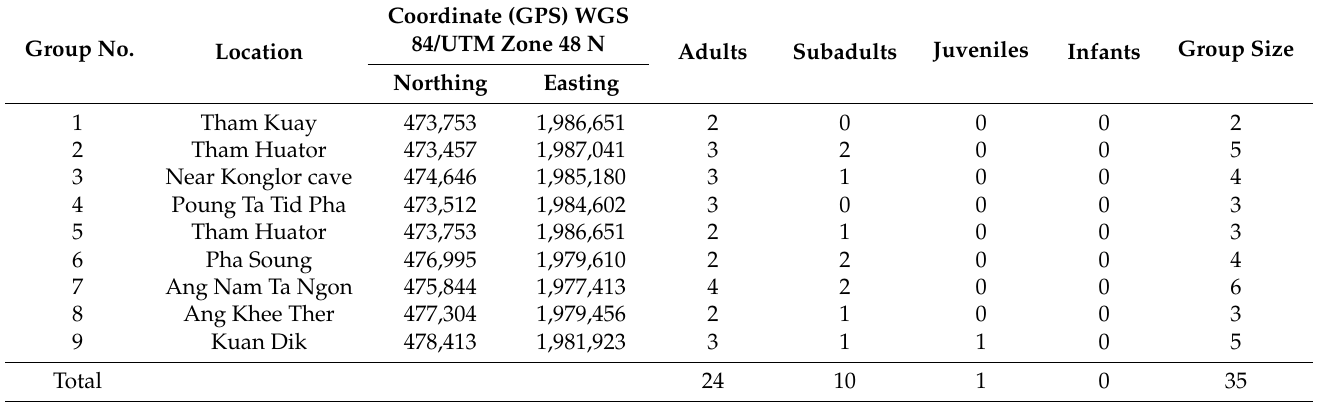
Table 4. Group size of the Laotian langur directly observed during this study.